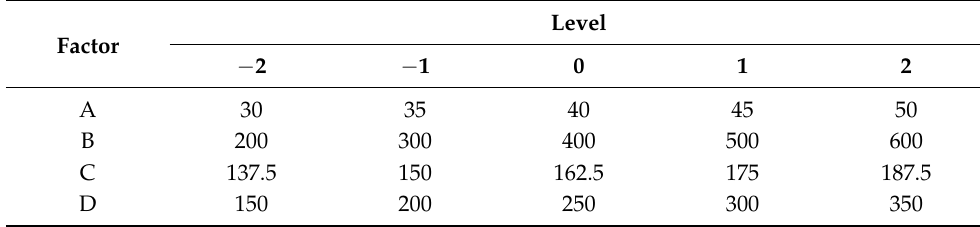
Table 5. Factor levels in the test.